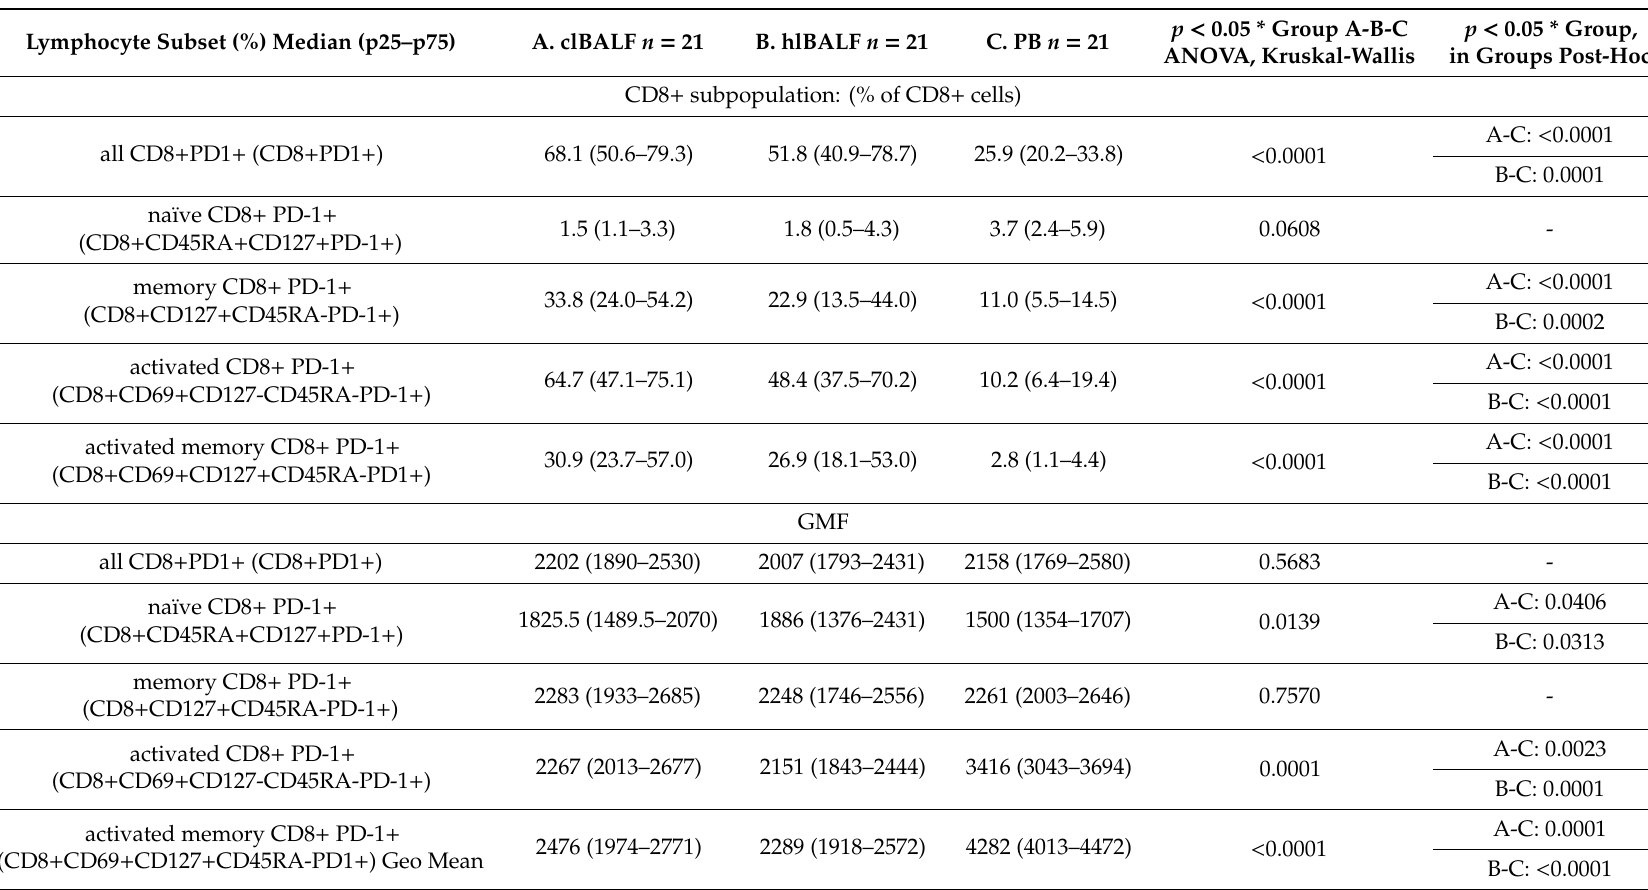
Table 3. Proportion of lymphocyte subtypes with the expression of PD-1 in patients with lung cancer and the geometric mean fluorescence (GMF) intensity of PD-1 on CD8, CD4 lymphocyte subpopulations. Comparison of the proportion of cells between three compartments: the tumor environment clBALF, ‘healthy’ lung (hlBALF), and peripheral blood (PB). Data expressed as median (p25–p75). Di ff erences between groups were assessed by the ANOVA Kruskal–Wallis test. * p < 0.001 between given compartment and peripheral